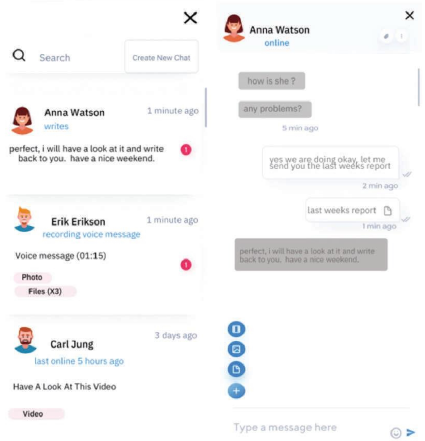
Figure 7: Previous design of the chat.